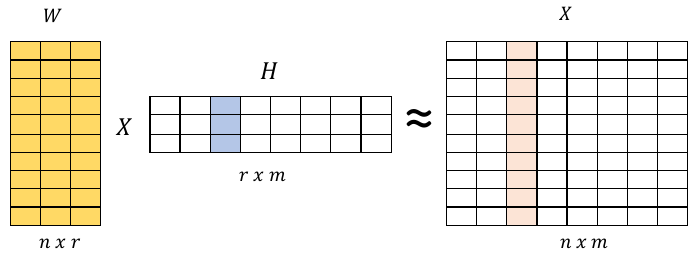
Figure 1. Non-negative matrix factorization.